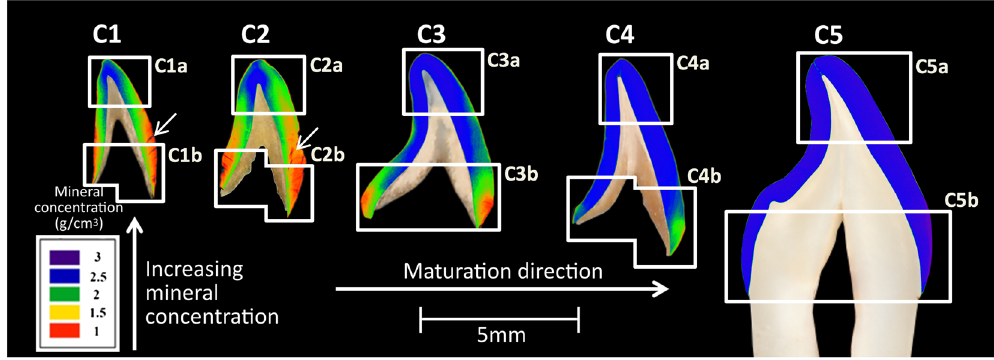
Figure 1. Mineral concentration distribution maps of central incisal enamel at various developmental stages. For each tooth section labial is on the right hand